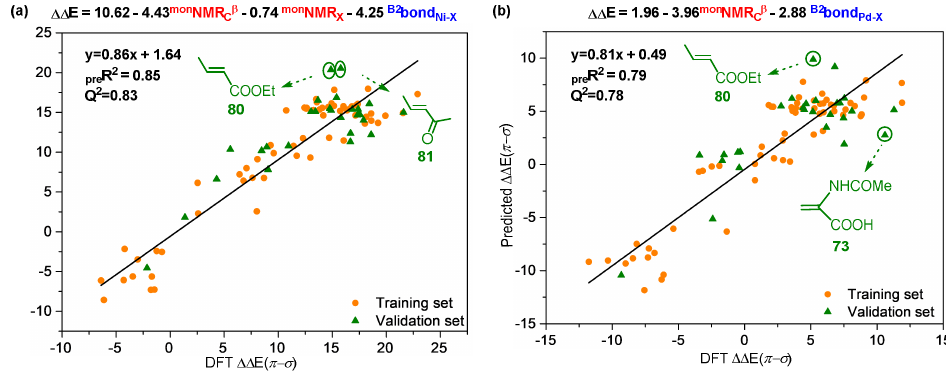
Figure 5. Plot of computed vs. predicted ∆∆ E (π-σ) (kcal/mol) for complexes II Ni ( a ) and II Pd ( b ) using the multivariate linear regression models.